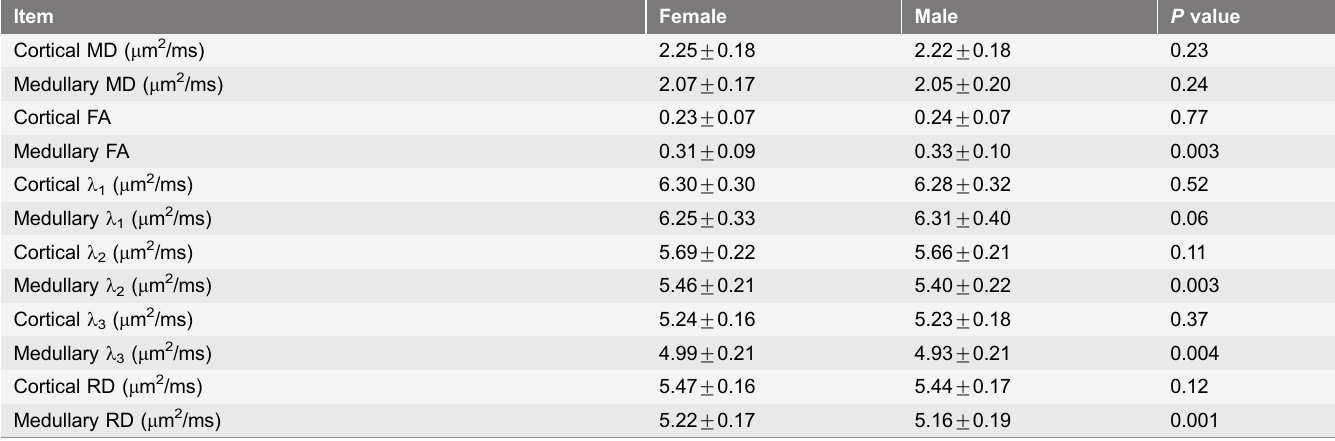
Table 4. DTI parameter index value by